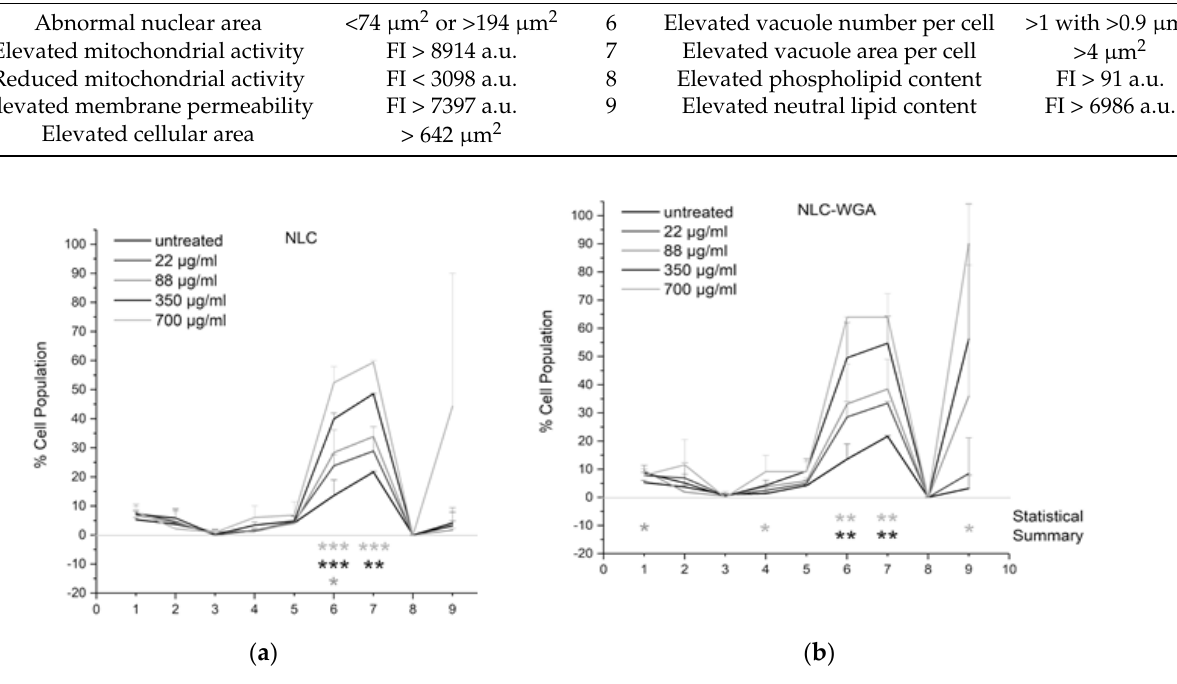
Figure 4. ( a ) Morphometric analysis of the macrophages exposed to blank lipid nanocarriers (NLC); ( b ) morphometric analysis of the macrophages exposed to lipid nanocarriers grafted with WGA. * p < 0.05; ** p < 0.01 and *** p < 0.001